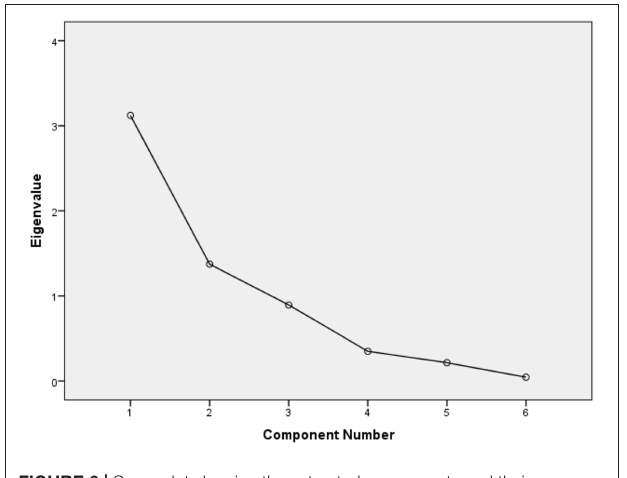
FIGURE 6 | Scree plot showing the extracted components and their corresponding eigenvalues. Three components present eigenvalue higher than 1. Only these were considered in the analysis.